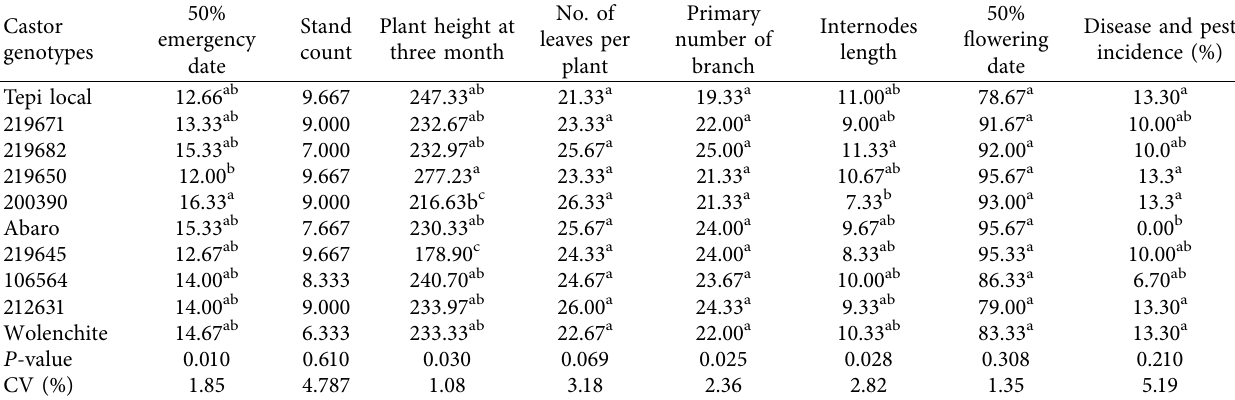
Table 1: Agronomic performance of castor genotypes under Tepi